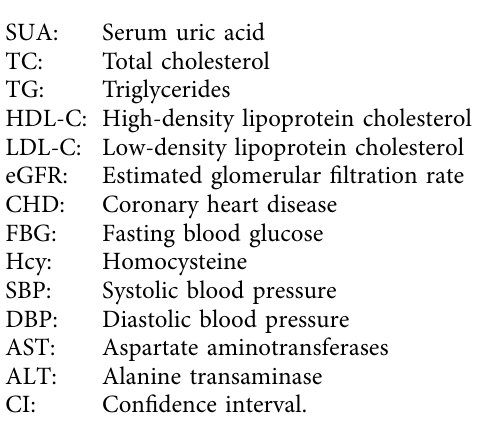
Table S4: results of subgroup analysis and interaction test (HDL-C). ( Supplementary Materials